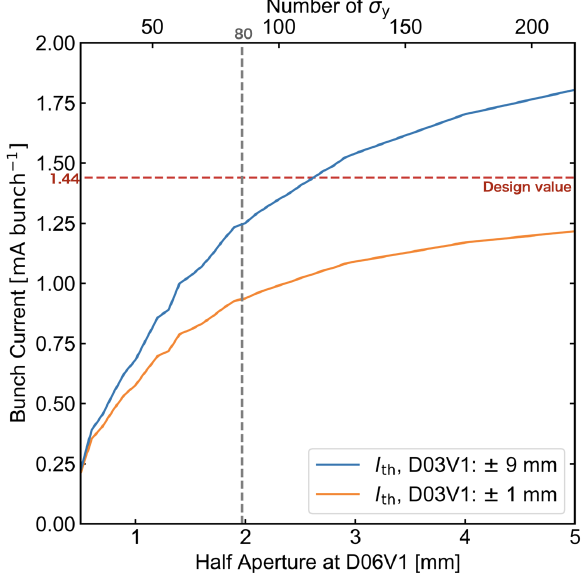
collimator.FIG. 9. Bunch current threshold owing to TMCI as a function of half aperture at D06V1 collimator in final optics configuration (beta function at IP: 0.27 mm; vertical emittance: 0.64 pm). The transverse kick factor is calculated with GDFIDL . The vertical beta functions for the collimators are 111.75 m at D02V1, 16.96 m at D03V1, 19.24 m at D06V2, and 61.44 m at D06V1. The apertures in the D02V1 and D06V2 collimators are set to (cid:2) 2 mm ( 80 σ y ) and (cid:2) 9 mm ( 698 σ y ),